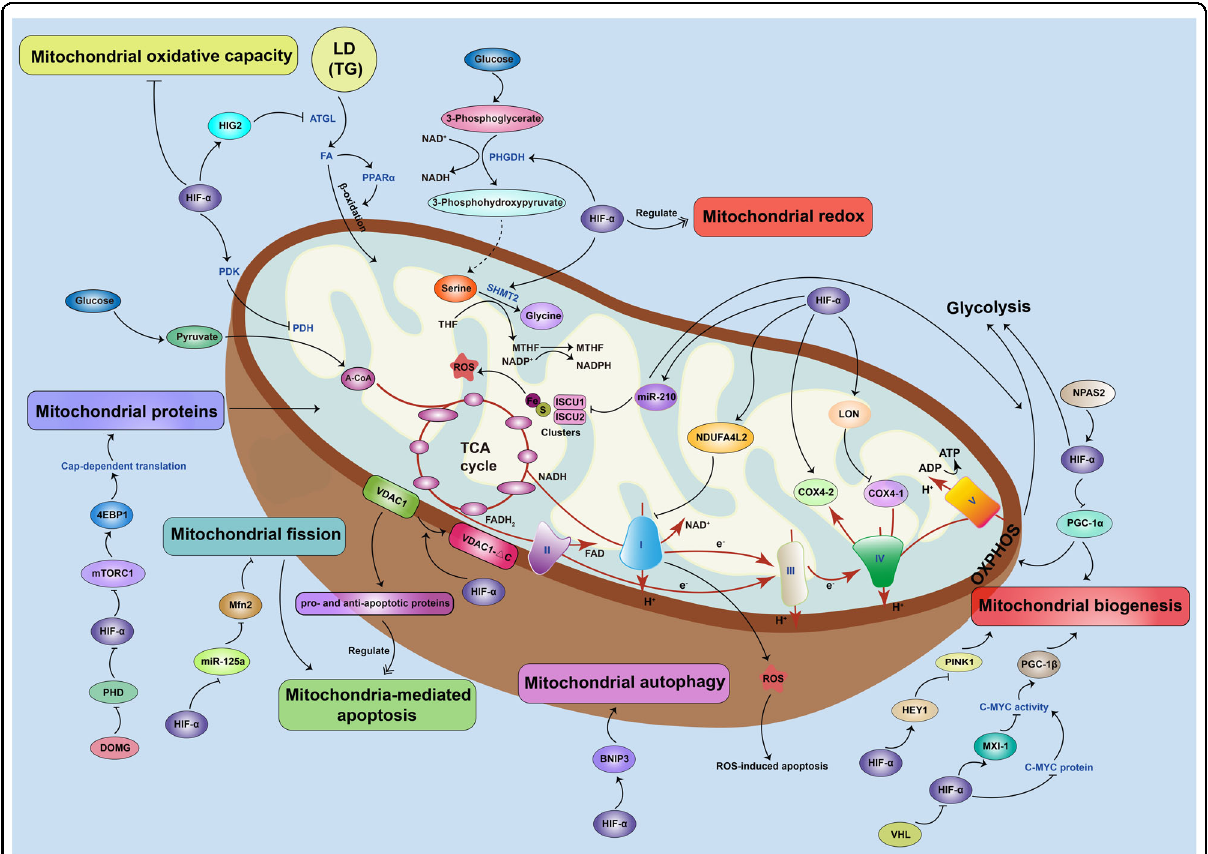
Fig. 4 Function of HIFs on mitochondrial dysfunction. HIFs have an effect on multiple mitochondrial functions, including mitochondrial oxidative capacity, OXPHOS, biogenesis, apoptosis, fi ssion, and autophagy. HIF-1 activation downregulates mitochondrial oxidation by inhibiting ATGL- mediated lipolysis via HIG2, which leads to LD storage and subsequently declines mitochondrial FA oxidation under hypoxic conditions, and by inducing PDK, which inhibits PDH, thereby inhibiting the fl ow of pyruvate into the TCA cycle. HIF-1 also regulates mitochondrial redox by inducing mitochondrial serine catabolism and the production of NADPH. Furthermore, miR-210, which is upregulated by HIF-1, restrains expression of the Fe – S cluster assembly proteins ISCU-1 and ISCU-2, which further restricts mitochondrial ROS generation and induces a shift of energy metabolism from OXPHOS to glycolysis. HIF-1 stimulates the less active ETC components, including NDUFA4L2, COX4-1, COX4-2, complex I, and complex IV, to delay the electron transfer through the ETC, therefore blocking the accumulation of ROS and reducing ROS-mediated apoptosis. HIF-1 α reduces mitochondrial biogenesis by targeting PGC-1 α , MXI, and HEY1. Meanwhile, NPAS2 increases the expression of glycolytic genes by transcriptionally upregulating HIF-1 α . HIF-1 also regulates apoptosis by promoting the formation of VDAC1- Δ C from VDAC1. Mitochondrial fi ssion, which results in the activation of mitochondria-associated apoptosis, is negatively regulated by the HIF/miR-125a/Mfn2 pathways during carcinogenesis. Mitochondrial proteins can also be inhibited by suppression of the mTORC1/p70SK/S6 signaling pathway via action of HIF-1 α . HIF-1 α also induces BNIP3 to promote mitochondrial